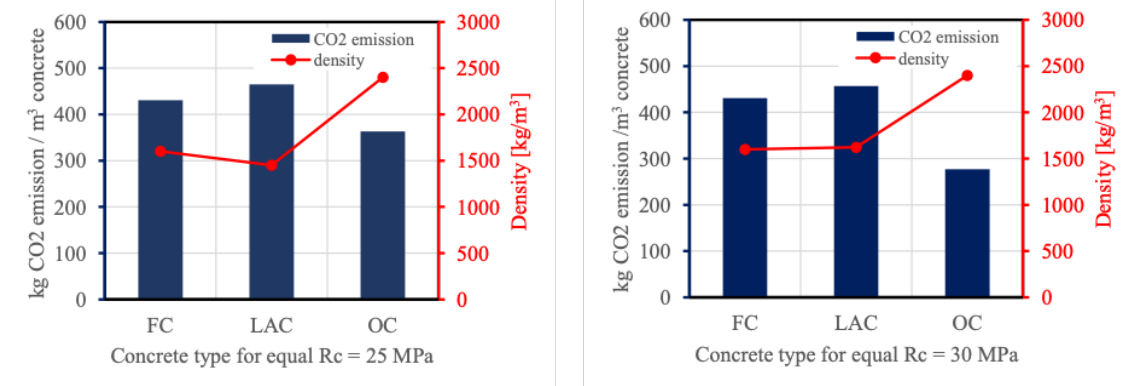
Figure 2. CO 2 emission comparison alongside related density values among three classes of concrete for equal compressive strength of 25 MPa (left) and 30 MPa (right).